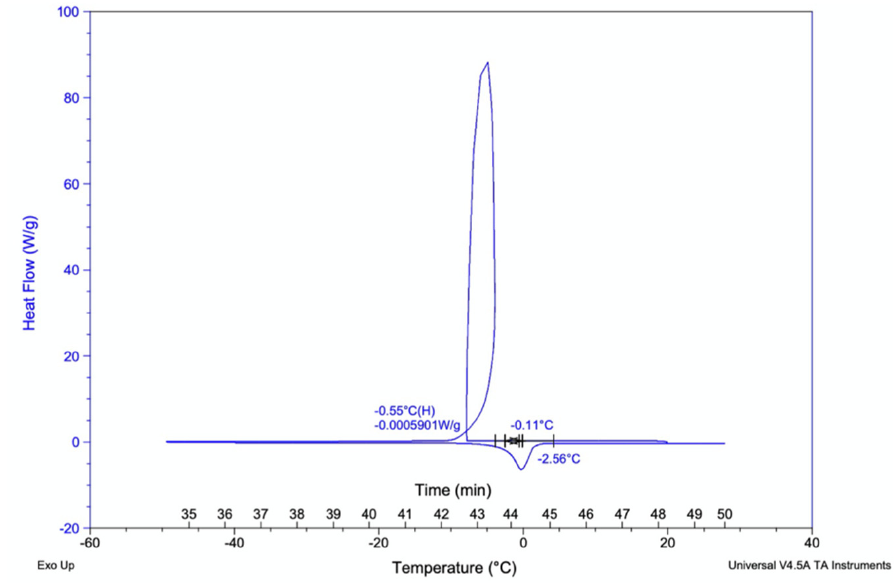
Figure 9. Glass-transition temperature curve for kombucha samples. The polymers begin transition to glass state at temperatures − 2.56 °C to − 0.11 °C. Heat flow (W/g).